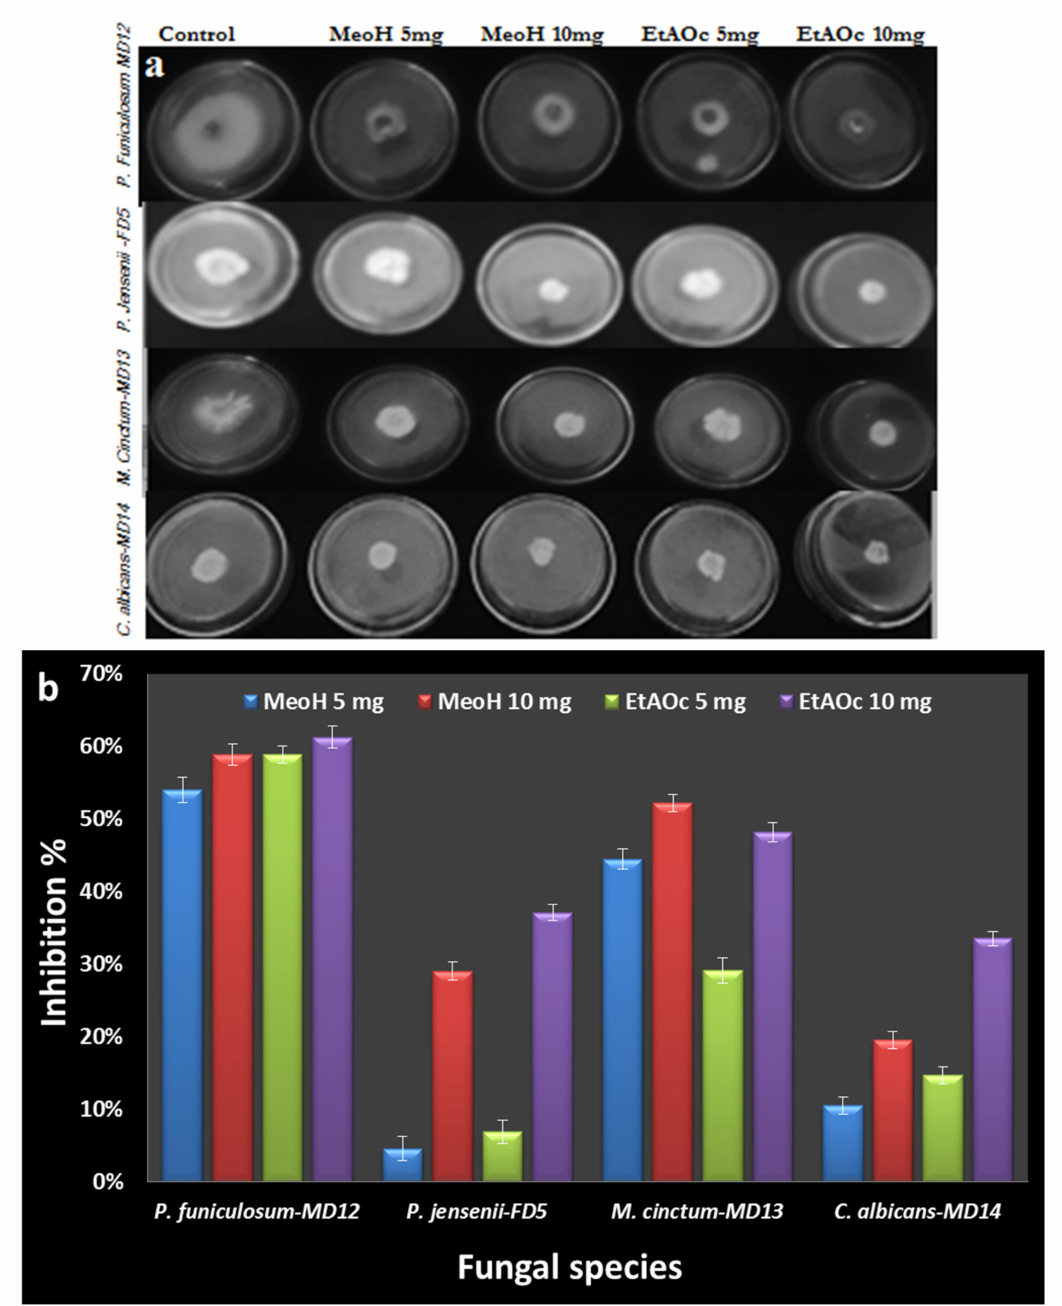
Figure 3. Screening of antifungal activity of Arghel plant extracts using food technique method. Inhibition of fungal growth in Sabroud medium supplemented with EtOAc and MeoH plant extracts at two concentrations (5 mg/mL and 10 mg/mL) compared with control ( a ). Histogram showed the inhibition percentage of pathogenic fungi isolated from contaminated wounds at 5 mg/mL and 10 mg/mL of both EtOAc and MeoH plant extracts ( b